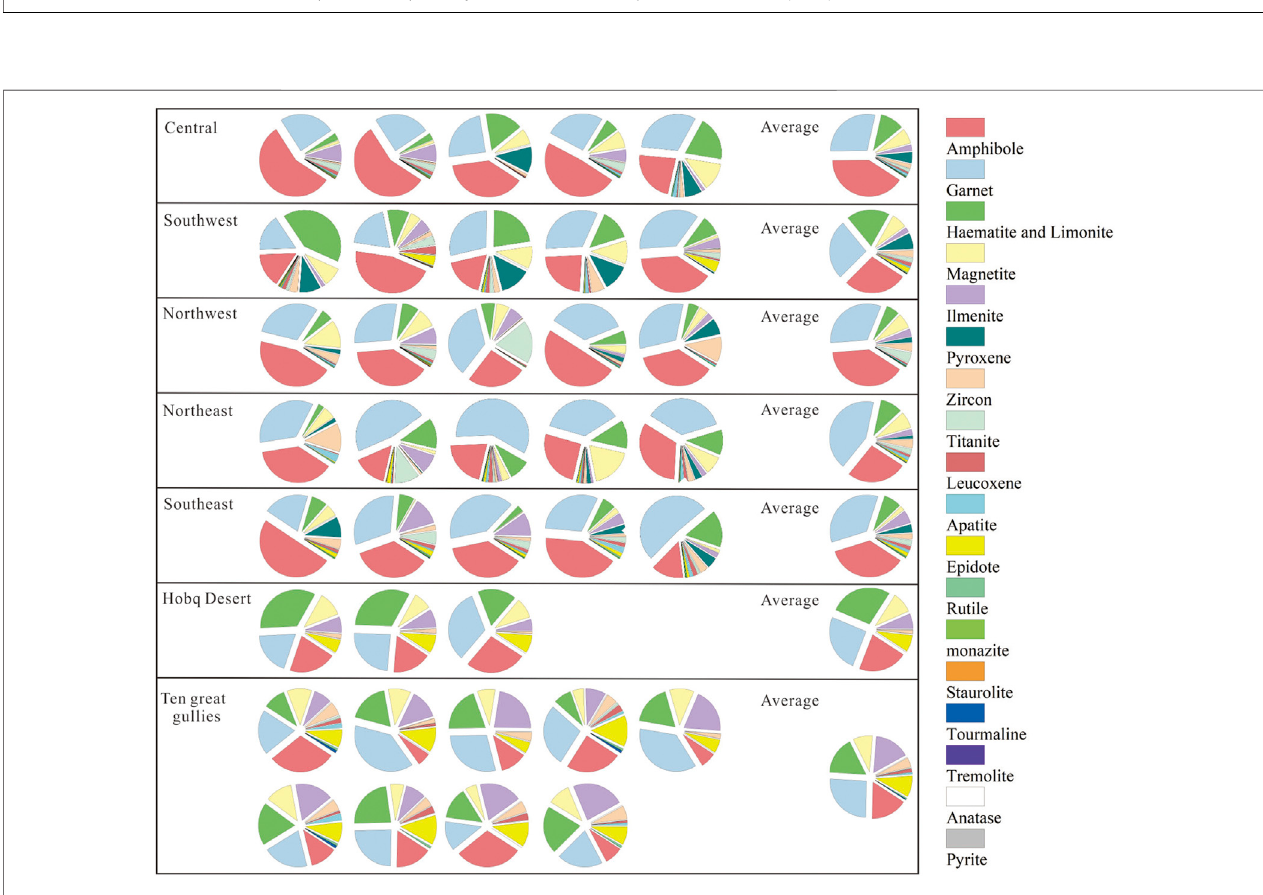
FIGURE 7 | Heavy-mineral assemblages of the samples. The data of Hobq Desert and Ten great gullies from Pan et al. (2016).